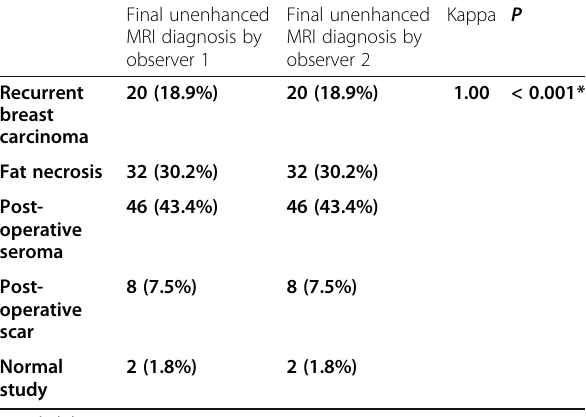
Table 6 Showed sensitivity, specificity, PPV, NPV, and diagnostic accuracy of unenhanced MRI by both